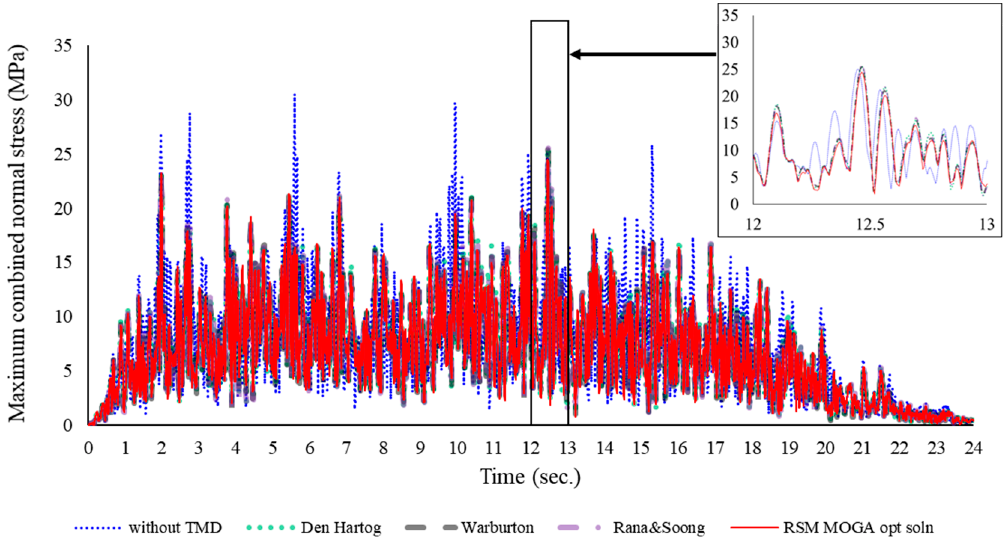
Figure 10. Comparison of the maximum combined normal stresses in the overall piping system. Table 5. Comparison of the maximum response ratios according to whether TMDs were installed and the difference between the optimal design formula/methods.